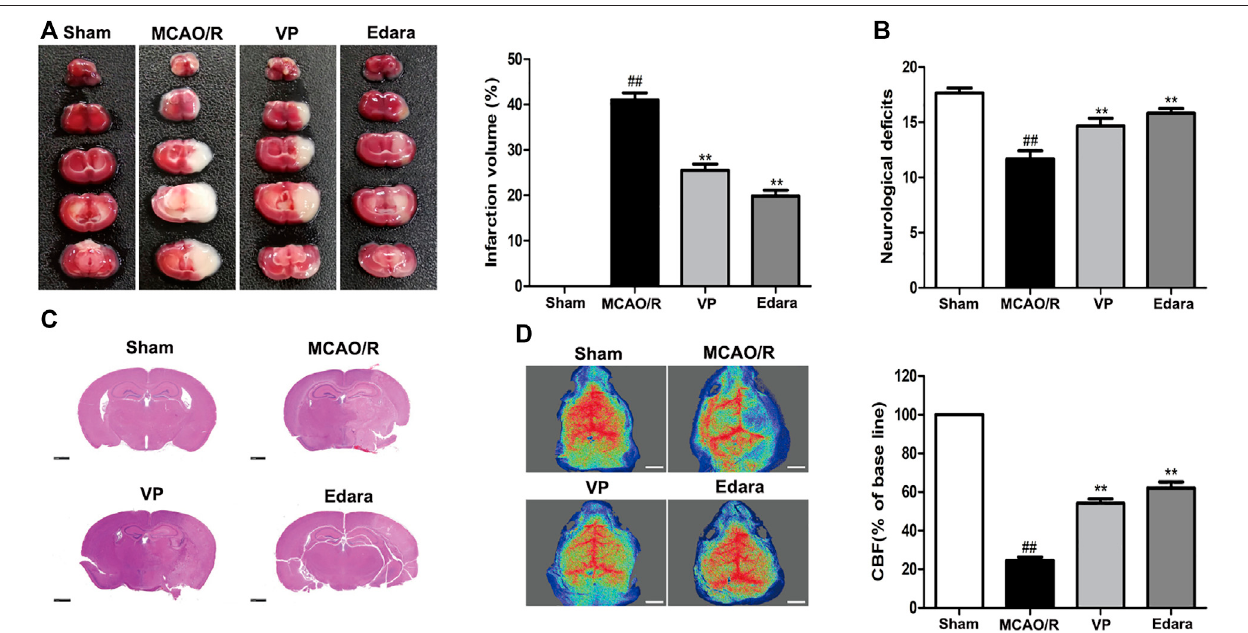
FIGURE3| EffectsofVPtreatmentonbraindamagecausedbyMCAO/Rinjuryinmice.Miceweresubjectedto1 hofischemiaand24 hofreperfusion.Micewere treated with VP (10 mg/kg) after 1 h of ischemia. (A) Mouse brains were evaluated for infarct volumes using TTC staining, which was quanti fi ed using imaging software, after I/R injury. (B) Quantitation of the neurological de fi cits measured in different groups. (C) H and E-stained images of mouse brain sections from different groups, examined under a light microscope. (D) CBF quanti fi cation in ischemic brain regions. Data are expressed as the mean ± SD, n (cid:1) 6. ## p < 0.01 vs . Sham group, ** p < 0.01 vs . MCAO/R group. Scale bar (cid:1) 50